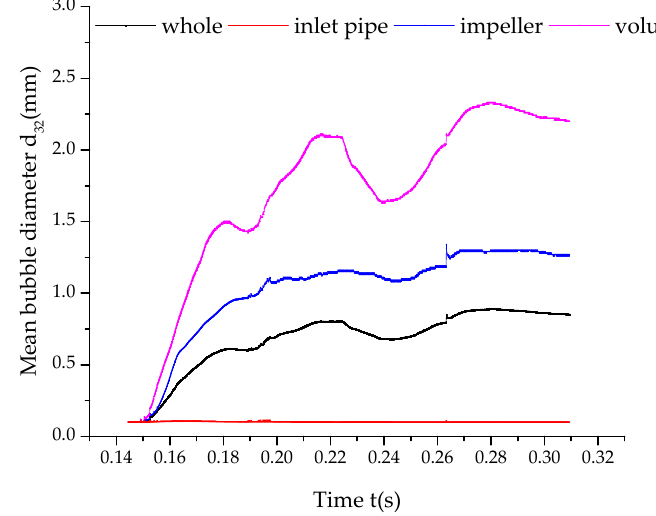
Figure 15. Variation of the mean bubble diameter with time of the main pump components.